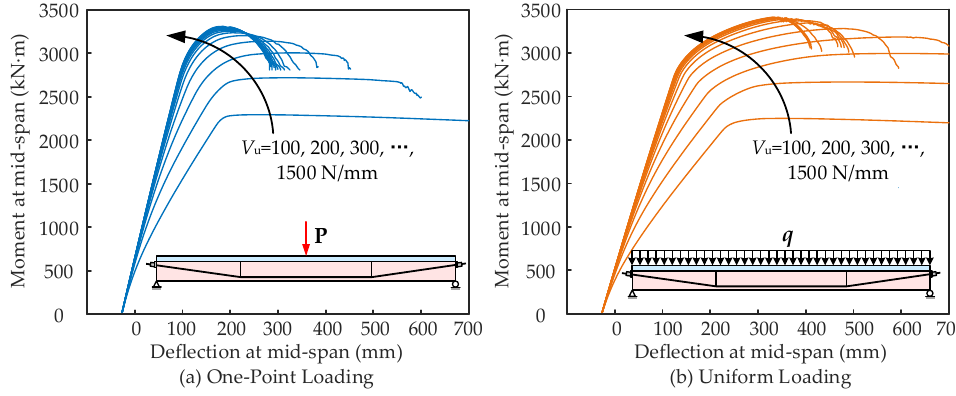
Figure 20. Load-displacement curves with different interfacial shear capacities.